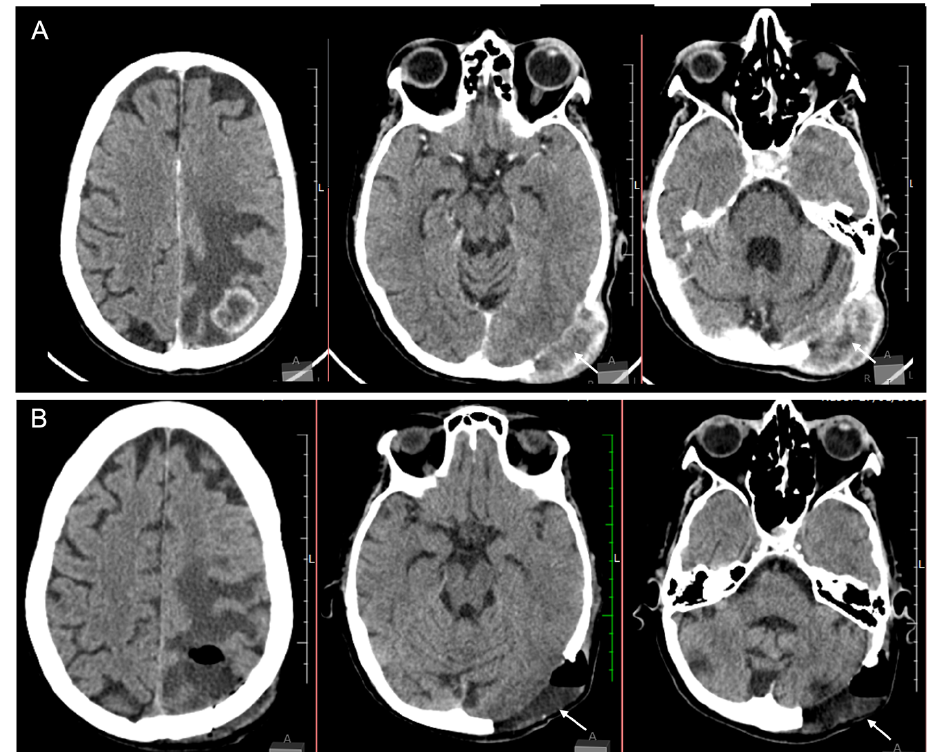
Figure 2. Computer tomography (CT scan) of the brain showing pre- ( A ) and postoperative images ( B ). ( A ) CT scan with venous contrast showing an intra-axial lesion on the occipital/parietal lobes and an infiltrative transcranial lesion in the occipital bone. ( B ) Postoperative image of both intracranial and transcranial lesions.